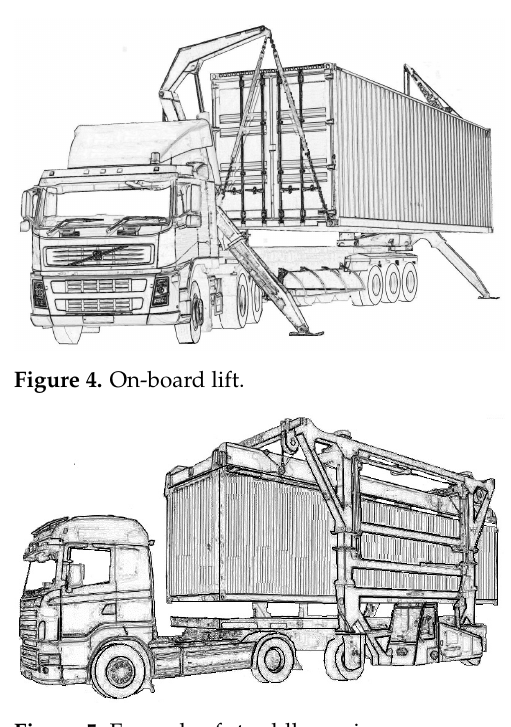
Figure 5. Example of straddle